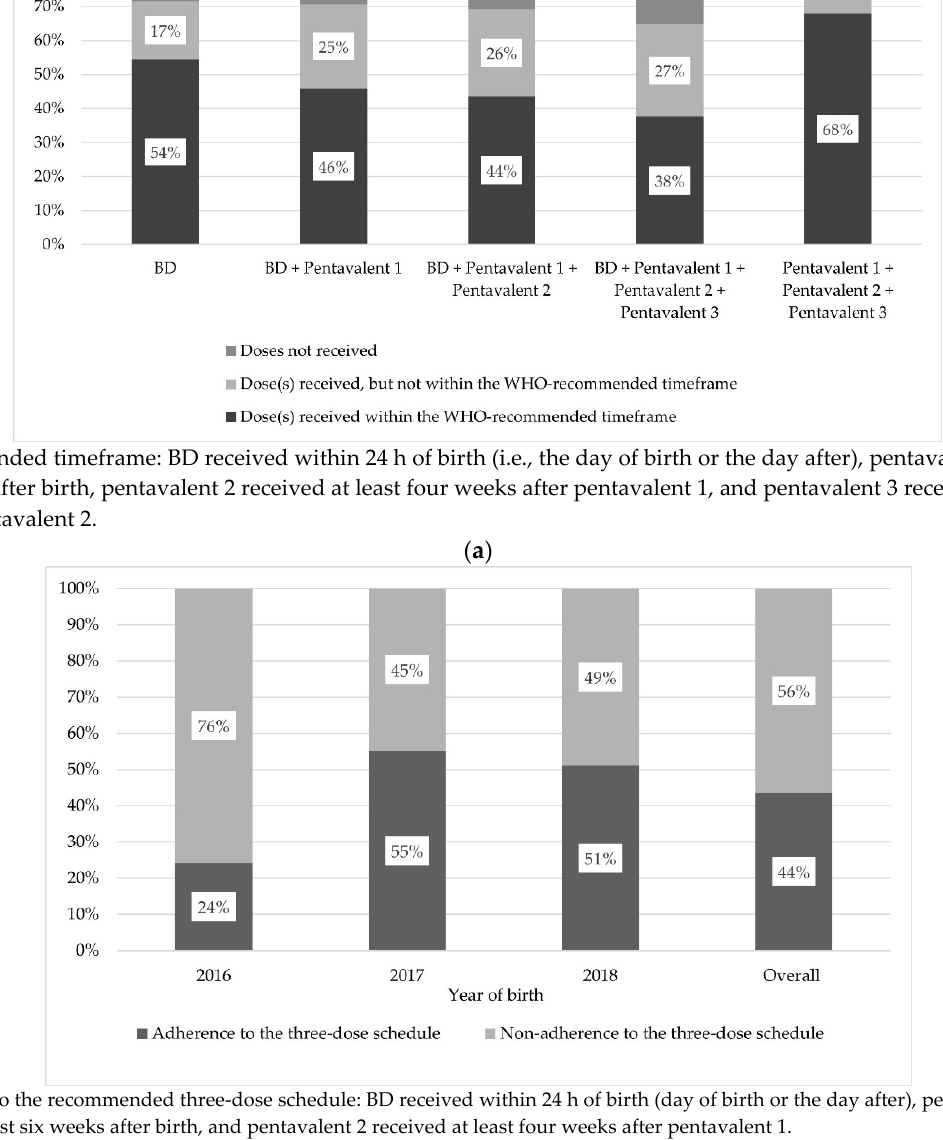
Figure 2. Coverage and timeliness of the WHO-recommended three-dose HBV vaccination schedule (i.e., Birth dose (BD) plus at least two doses of pentavalent vaccine) in children born after the BD was introduced in Senegal’s national Expanded Programme on Immunisation in 2016 (ANRS 12356 AmBASS survey, n = 241 children living in the mostly rural area of Niakhar with available vaccination data, using weighted and calibrated data). ( a ) HBV vaccine coverage and timeliness (percentage of children), per dose schedule; ( b ) Adherence and non-adherence (percentage of children) to recommended three-dose HBV vaccine schedule according to year of birth.